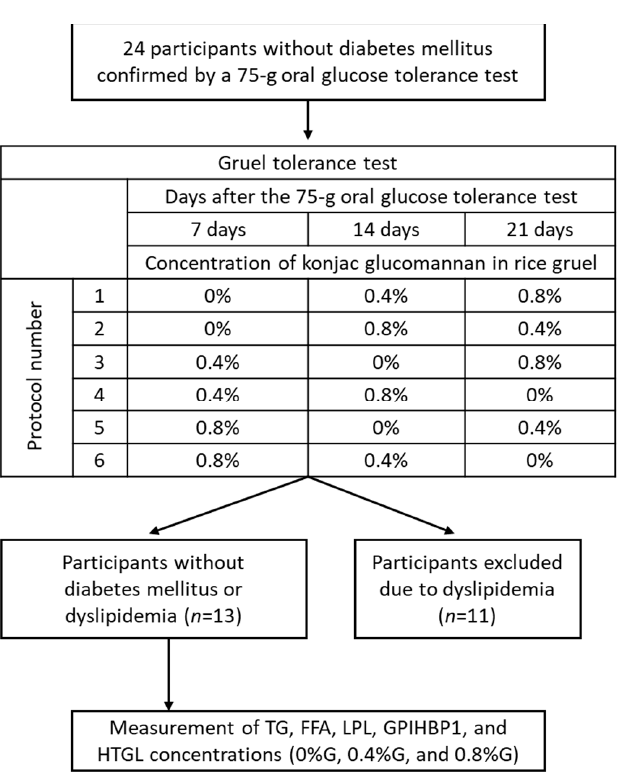
involved ingesting rice gruel supplemented with konjac glucomannan at 3 different concentrations (0%, 0.4%, and 0.8%)